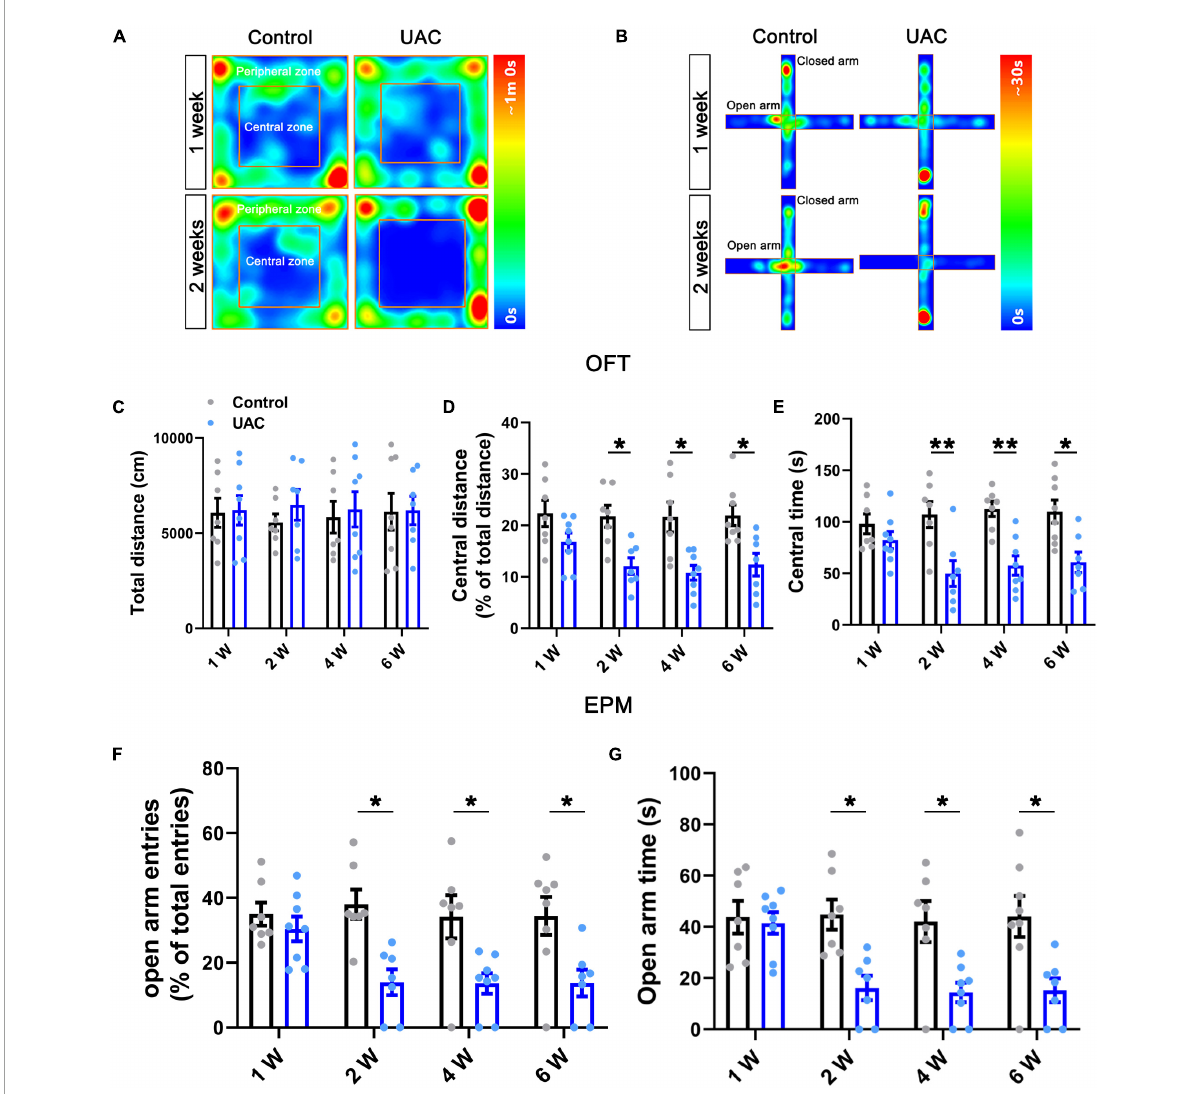
FIGURE1 Mice with UAC showed anxiety-like behaviors. Heatmap during the OFT (A) and EPM (B) showing the effects of UAC in mice. Top: 1 week after UAC; bottom: 2 weeks after UAC. General locomotor activities was assessed by the total distance traveled (C) and anxiety-like behaviors were assessed by the percentage of central distance (distance traveled in the central area versus the total distance traveled) (D) and the time spent in central area (E) in the OFT and the percentage of open arm entries (open arms entries versus total entries) (F) and the time spent in the open arms (G) in the EPM after 1 week (Control: n = 7; UAC: n = 8), 2 weeks (Control: n = 7; UAC: n = 7), 4 weeks (Control: n = 7; UAC: n = 8) and 6 (Control: n = 8; UAC: n = 7) weeks of UAC. Data are presented as the mean ± SEM. * P < 0.05, ** P < 0.01, compared with the control